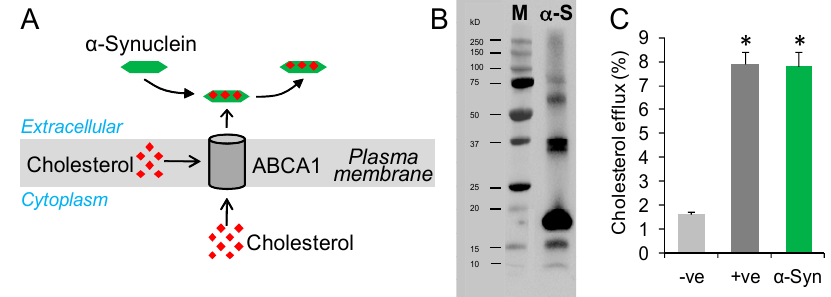
Figure 1. α -Synuclein mediates cholesterol efflux. ( A ) A putative model of cholesterol efflux process controlled by the transporter protein ABCA1; ( B ) A preparation of α -synuclein ( α -S) protein displaying monomeric and oligomeric forms as analyzed by western blotting; standard protein marker (M); ( C ) Cholesterol efflux of SK-N-SH neuronal cells treated with exogenous α -synuclein (1.0 µ g/mL) compared to − ve control (PBS) and +ve control (apoE). Data represent mean ( n = 6) and SE as error bars, * p < 0.00005.